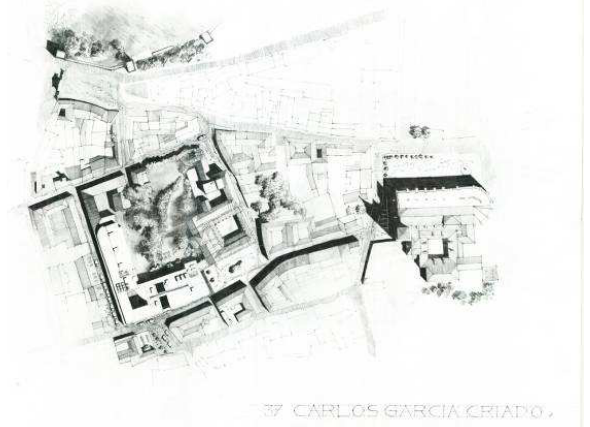
Figure 14. Urban land